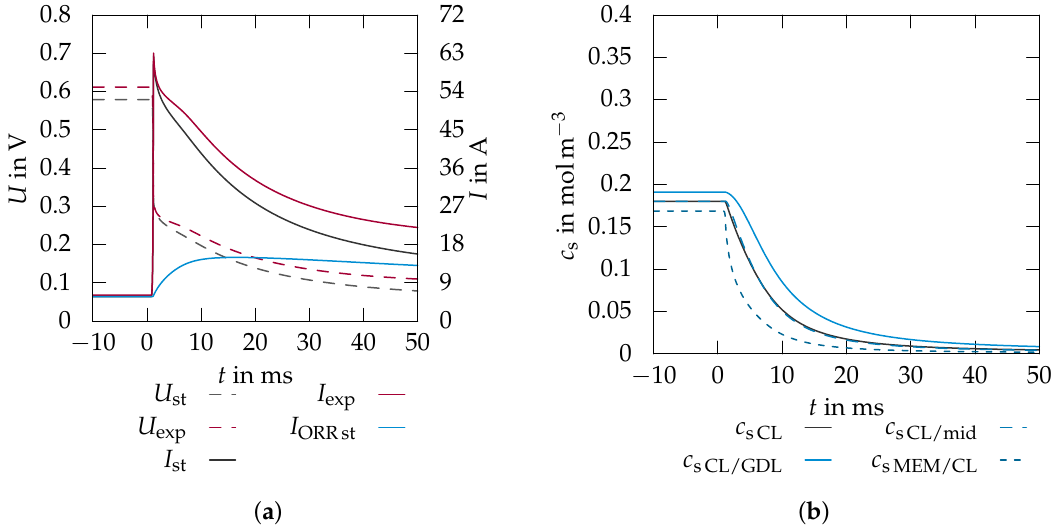
Figure 18. ( a ) Current (solid) and voltage (dashed) from the simulation with the experimental and the stoichiometric volume flux. ( b ) Average oxygen concentration at the centre of the agglomerate in the CL from the simulation with 0.1 Ω stationary load prior to the SC at different